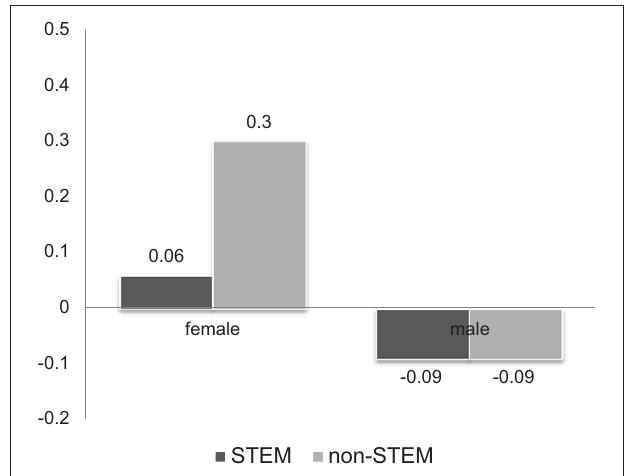
FIGURE 2 | Masculinity index of chemistry and career aspirations.